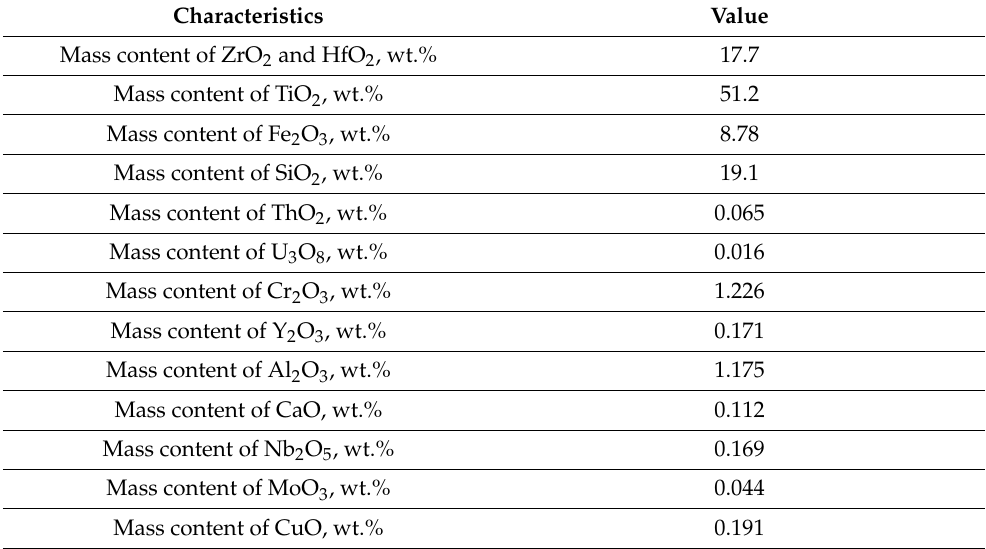
Table 11. Chemical composition. Characteristics Value Mass content of ZrO 2 and HfO 2 ,